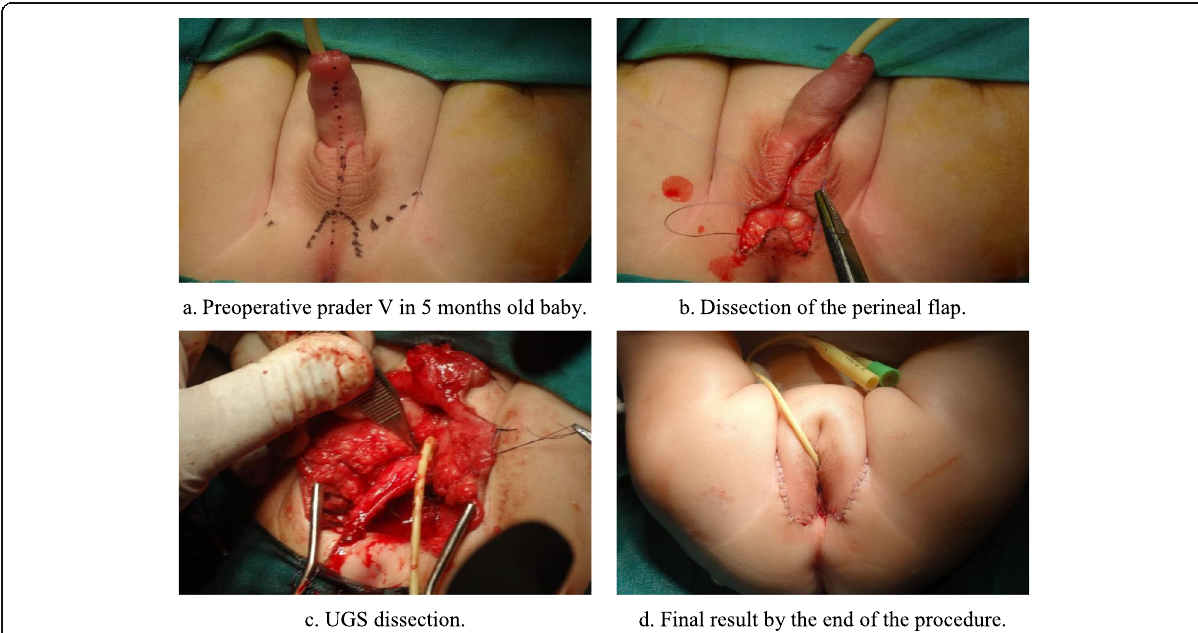
Fig. 2 a Preoperative Prader V in 5 months old baby. b Dissection of the perineal flap. c UGS dissection. d Final result by the end of the